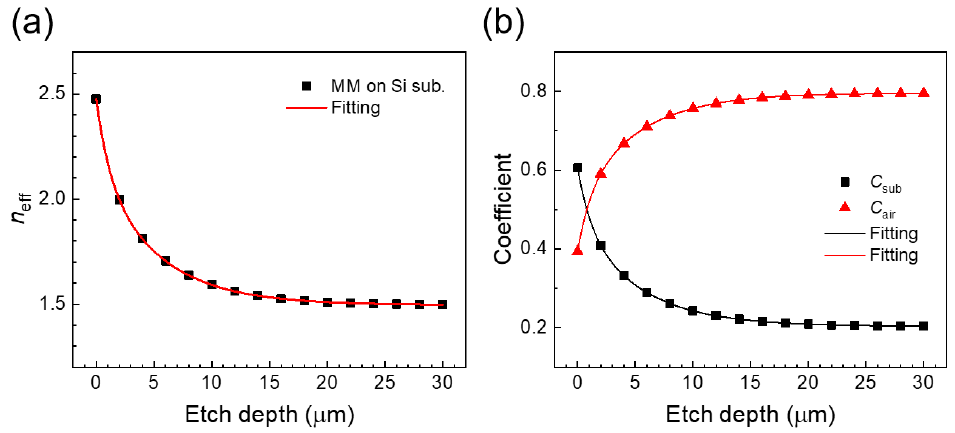
Figure 3. ( a ) n e ff as a function of substrate etch depth. ( b ) A plot of coe ffi cient C sub and C air as a Figure 3. ( a ) n eff as a function of substrate etch depth. ( b ) A plot of coefficient C sub and C air as a function function of substrate etch of substrate etch depth.